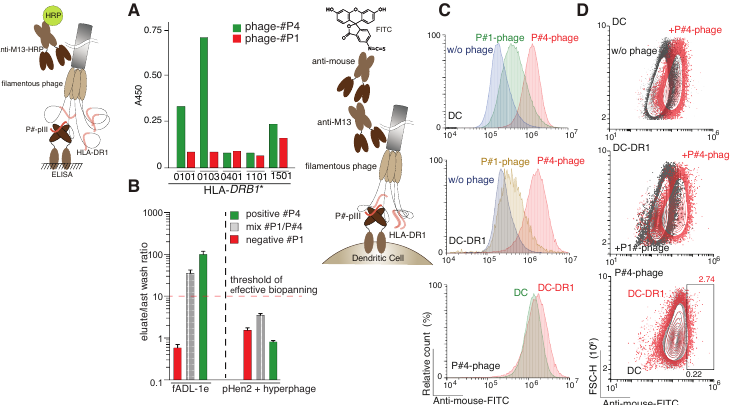
Figure 4. Selection of the HLA class II ligands. ( A ) Binding of peptide ligands exposed on the phage particles by various recombinant HLA-DRB1 molecules (0101, HLA-DRB1*0101; 0103, HLA-DRB1*0103; 0401, HLA-DRB1*0401; 1101, HLA-DRB1*1101; 1501, HLA-DRB1*1501) measured by ELISA; ( B ) The HLA class II peptide epitope selection by fADL-1e-based (left) and pHen2-based (right) phage display. Ligand–receptor interaction was studied by incubating the recombinant HLA-DR1 (in complex with HLA-DM) with its peptide ligand (P#4) itself or in mixture with irrelevant peptide P#1 (P#4 / P#1 ratio